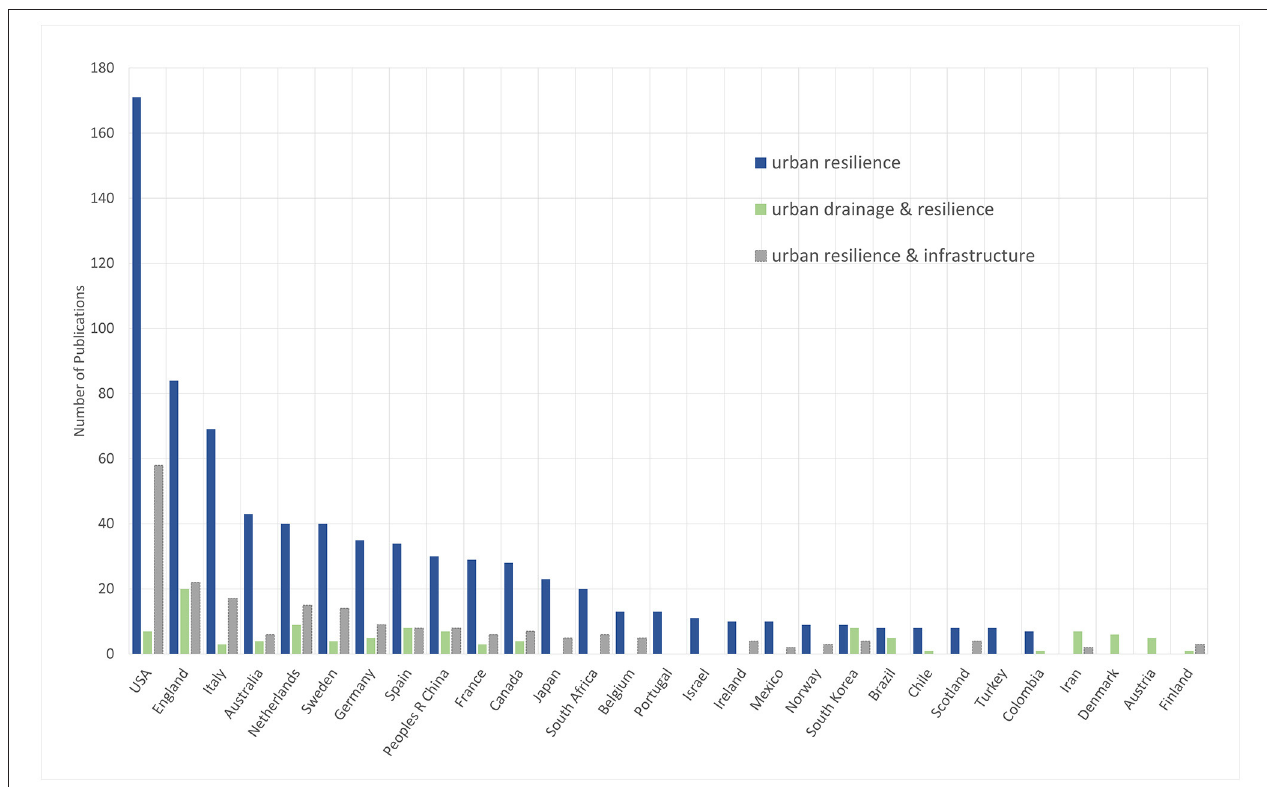
FIGURE 1 | Numbers of publications per country for urban resilience, urban drainage & resilience, and urban resilience & infrastructure. Pinson, 2002; Gleeson et al., 2004; Davidson and Arman, 2014; Nguyen et al.,